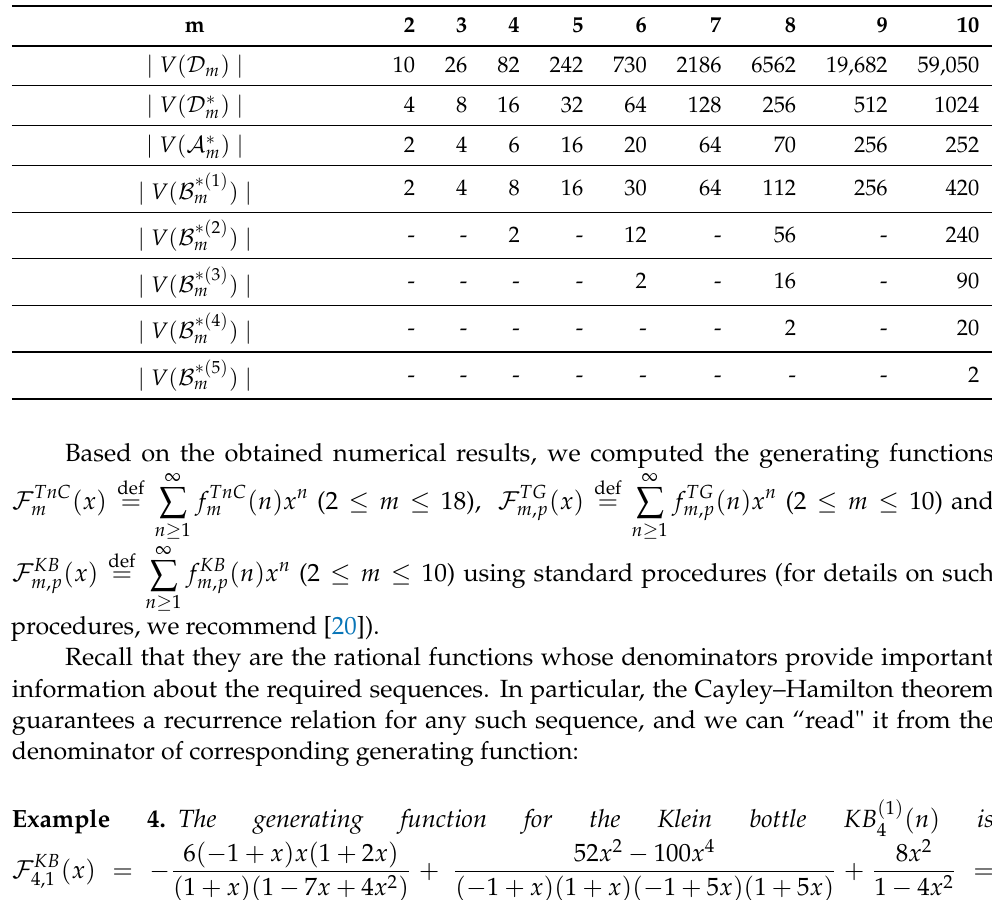
Table 2. The number of vertices of D m , D ∗ m and components of D ∗ m .